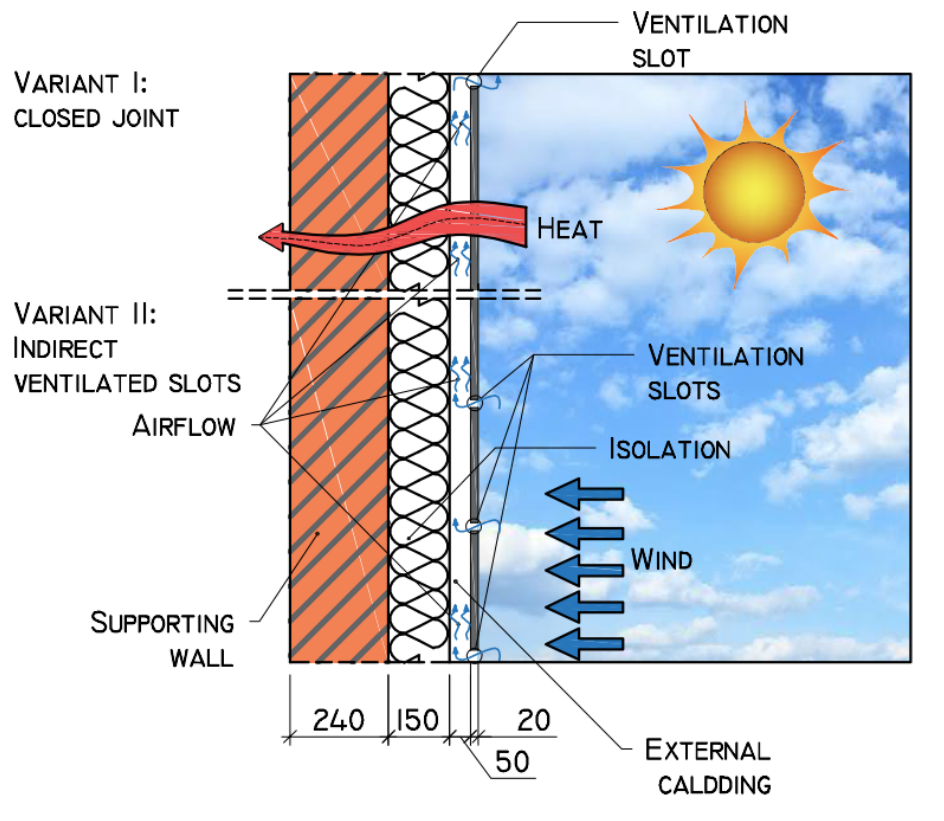
Figure 5: Facade diagrams for numerical simulations of ventilated